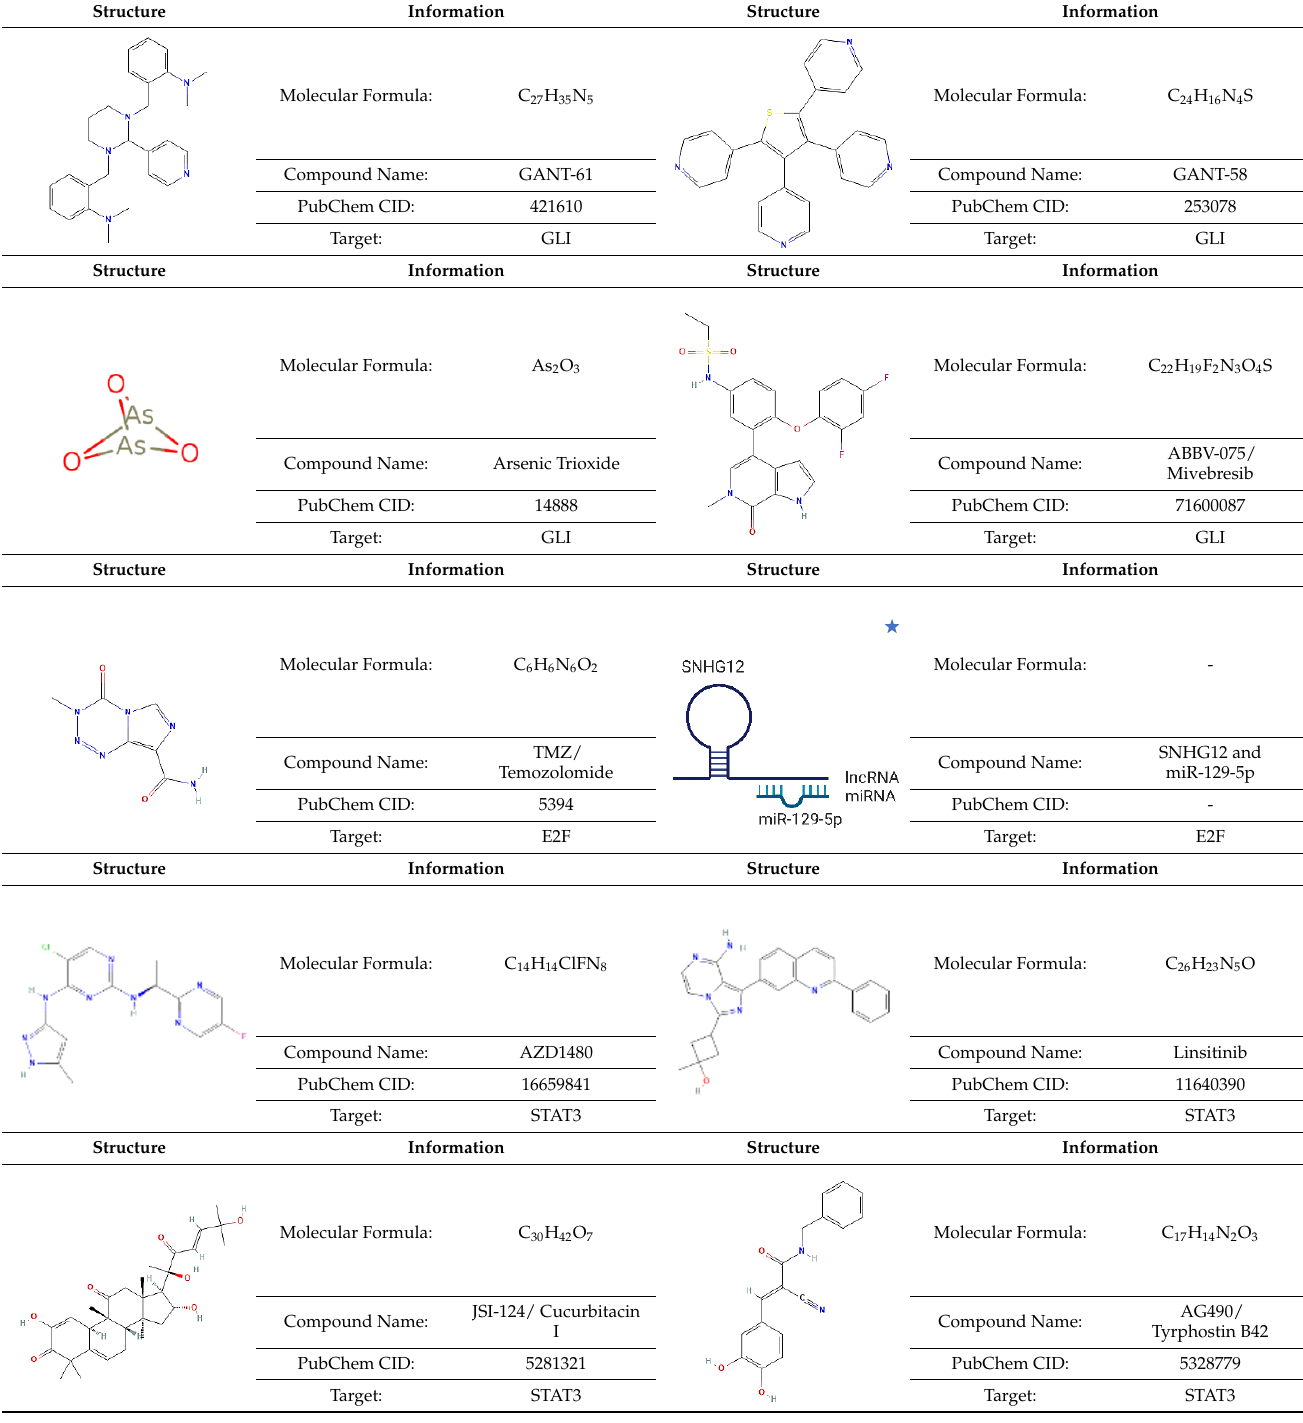
giogenesis contributing to the aggressive nature and recurrence of the disease. They have Table 1. Candidate compounds and molecules that interact either directly or indirectly with glioma- also emerged as therapeutic targets and tools with prognostic values (Table 1). related TFs. Structures and relevant information of several TF-related candidate compounds that Table 1. Candidate compounds and molecules that interact either directly or indirectly with glioma- Table 1. Candidate compounds and molecules that interact either directly or indirectly with glioma- Table 1. Candidate compounds and molecules that interact either directly or indirectly with glioma- Table 1. Candidate compounds and molecules that interact either directly or indirectly with glioma- could potentially be deployed in the battle against Table 1. Candidate compounds and molecules that interact either directly or indirectly with glioma- related TFs. Structures and relevant information of several TF-related candidate compounds that related TFs. Structures and relevant information of several TF-related candidate compounds that related TFs. Structures and relevant information of several TF-related candidate compounds that related TFs. Structures and relevant information of several TF-related candidate compounds that Table 1. Candidate compounds and molecules that interact either directly or indirectly with glioma- related TFs. Structures and relevant information of several TF-related candidate compounds that Table 1. Candidate compounds and molecules that interact either directly or indirectly with glioma- Table 1. Candidate compounds and molecules that interact either directly or indirectly with glioma- could potentially be deployed in the battle against gliomas. could potentially be deployed in the battle against gliomas. could potentially be deployed in the battle against gliomas. could potentially be deployed in the battle against gliomas. related TFs. Structures and relevant information of several TF-related candidate compounds that could potentially be deployed in the battle against gliomas. related TFs. Structures and relevant information of several TF-related candidate compounds that related TFs. Structures and relevant information of several TF-related candidate compounds that could potentially be deployed in the battle against gliomas. could potentially be deployed in the battle against gliomas. could potentially be deployed in the battle against gliomas.